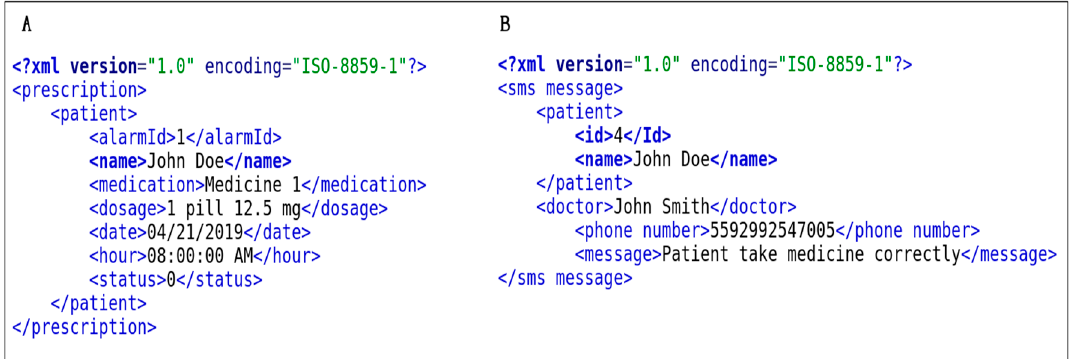
Figure 6. Warning and message data in XML format.